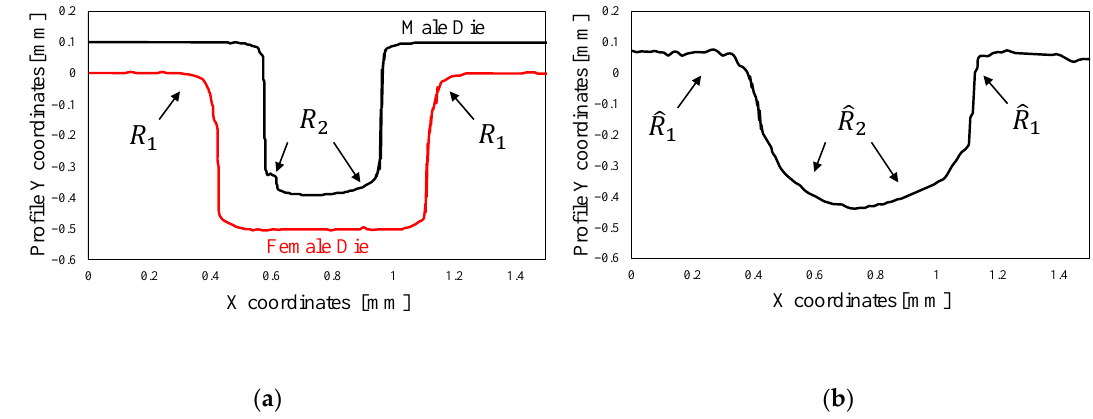
Figure 14. 2D profile shape determined for micro-stamping condition 4.28 with an Alicona surface profilometer ( a ) Male and female stamping die ( b ) Formed micro channel shape (bottom sheet